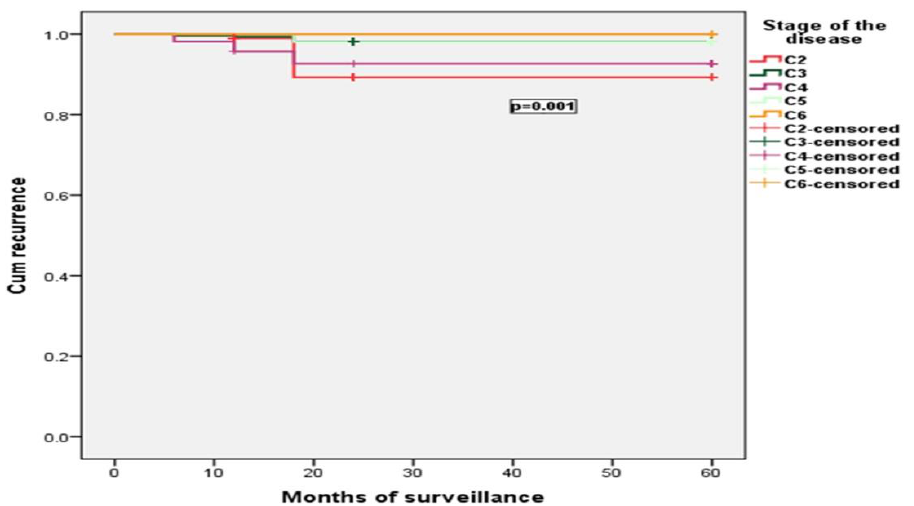
Figure 3. The frequency of recurrence was statistically significantly influenced by the CVD stage ( p < 0 .001).